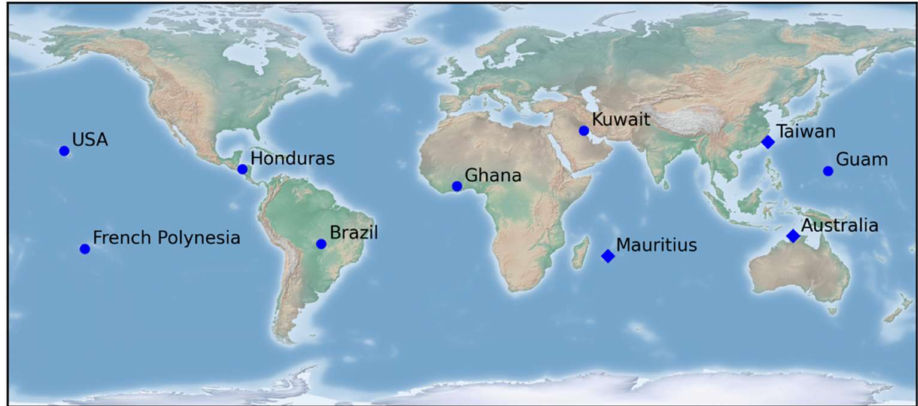
Figure 1. COSMIC-2 ground station locations. Circle markers denote downlink stations and diamond markers indicate downlink/uplink capable